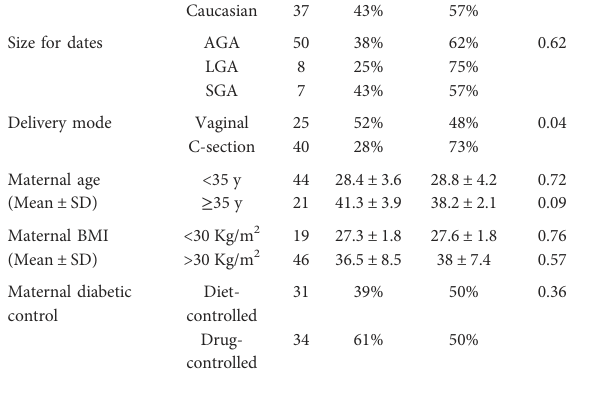
TABLE 3 The in fl uence of the independent variable on the hypoglycemia risk.